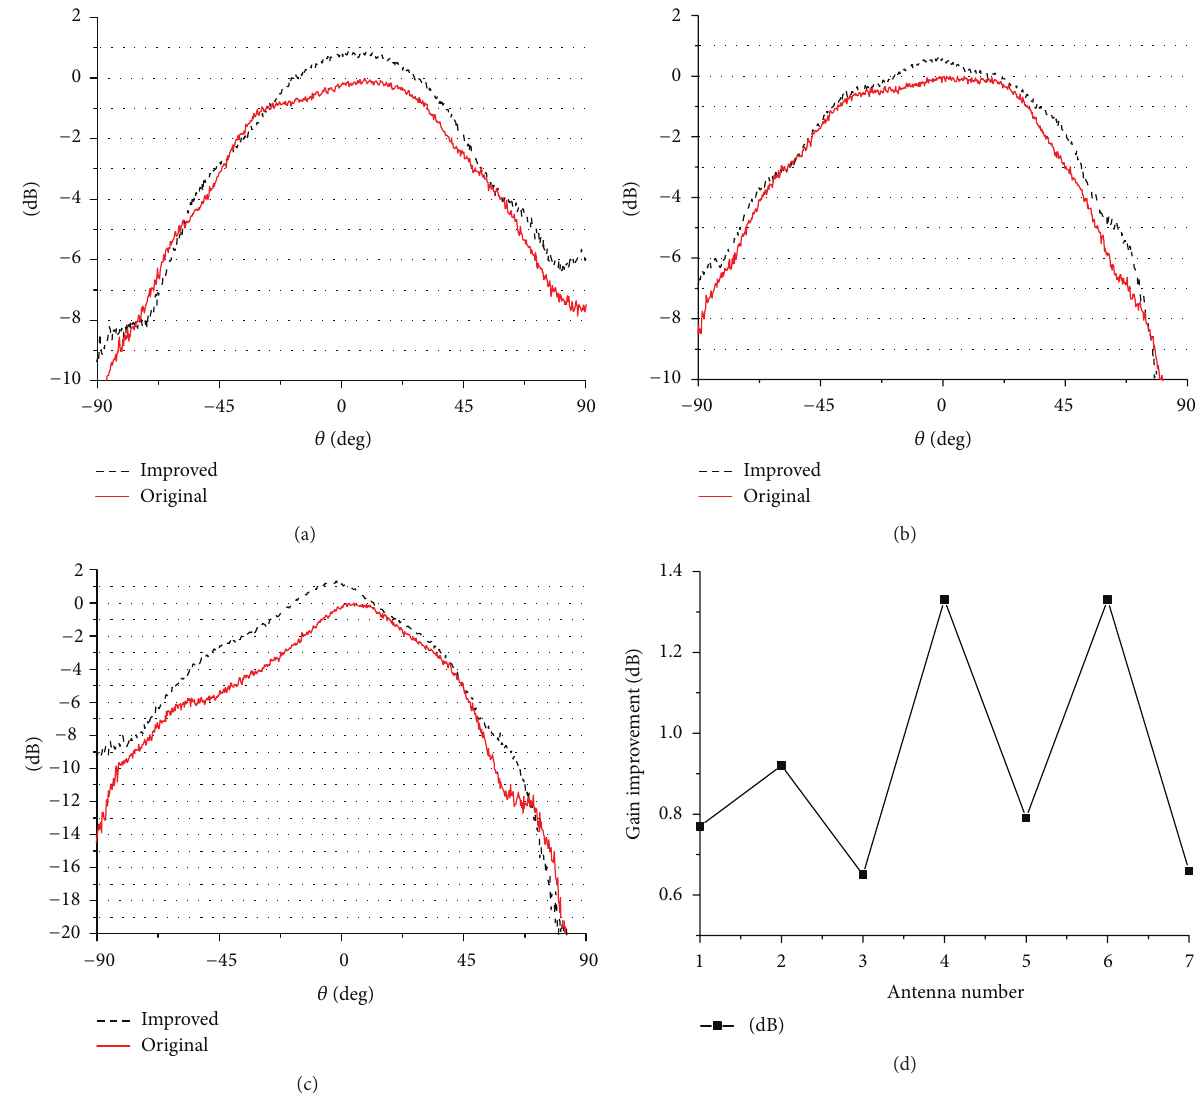
Figure 8: Comparing between improved pattern and original pattern: (a) number 2 component, (b) number 4 component, (c) number 6 component, and (d) efficiency/gain improvement